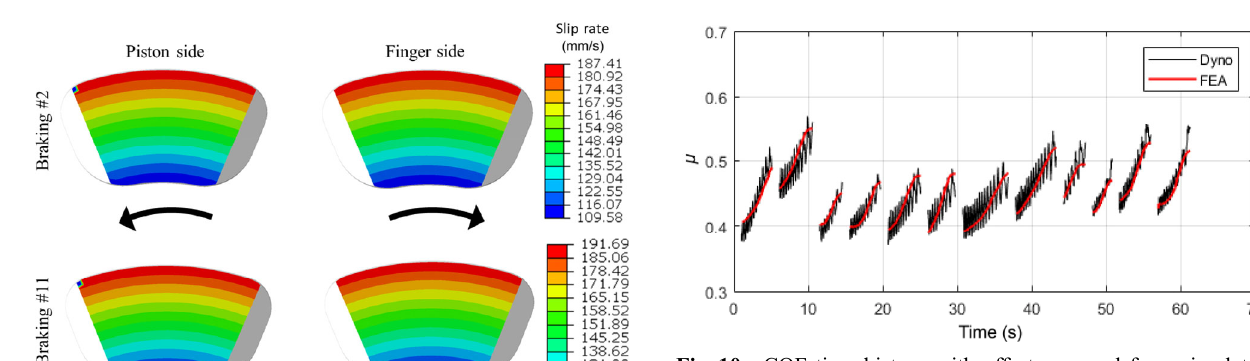
Fig. 10 COF time history with offset removed from simulated curve. Experimental COF in black, FEA COF in